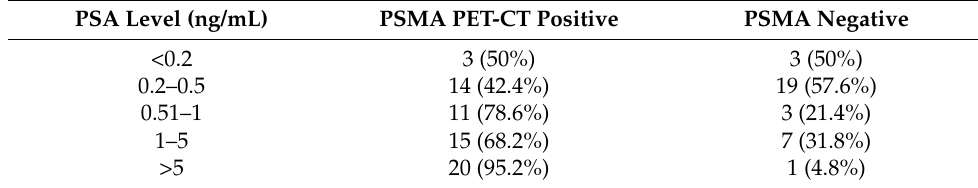
Table 3. PSMA PET-CT results stratified by PSA level.